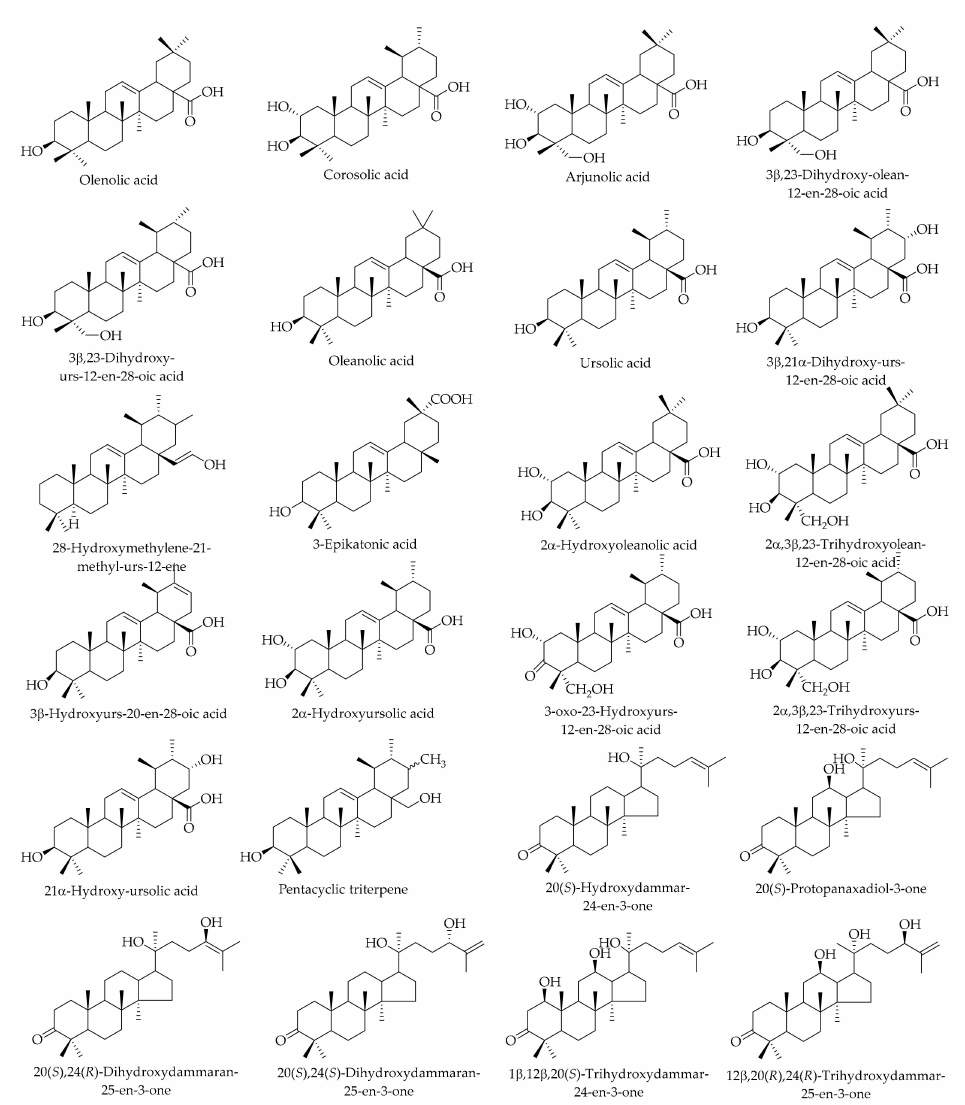
Figure 13. The chemical structures of di ff erent identified, isolated, and quantified triterpenoids in the green husk of